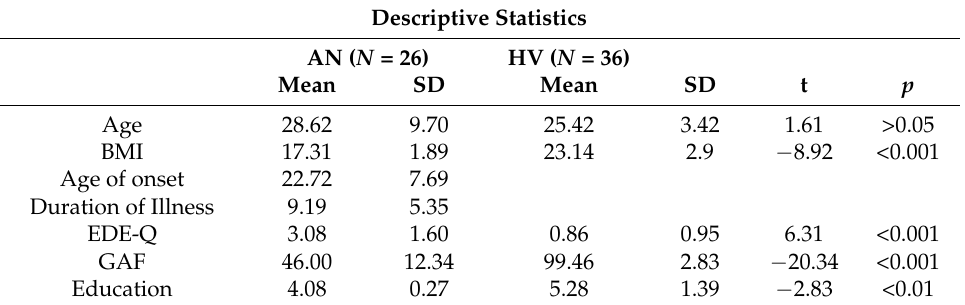
Table 1. Result of independent samples t-test comparing descriptive statistics between patients with AN at baseline and